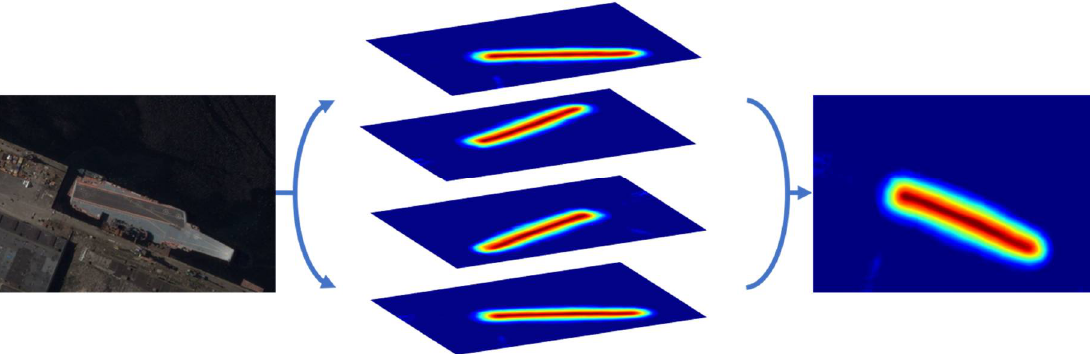
Figure 7. Test time augmentation.